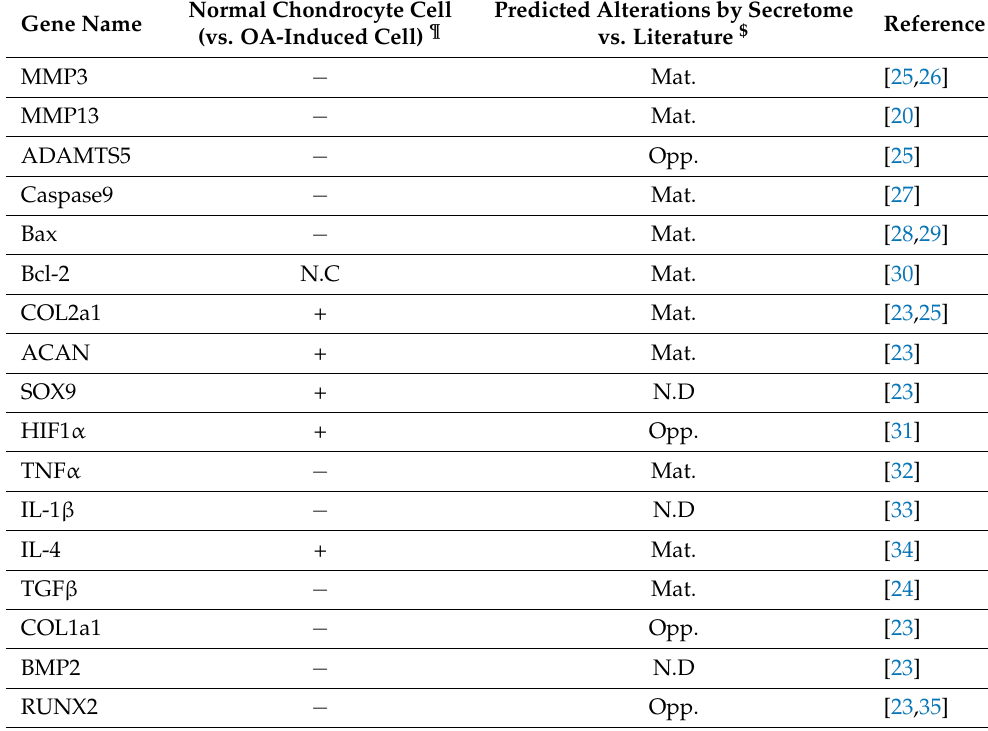
Table 1. Genes reported to alter depending on osteoarthritis (OA)